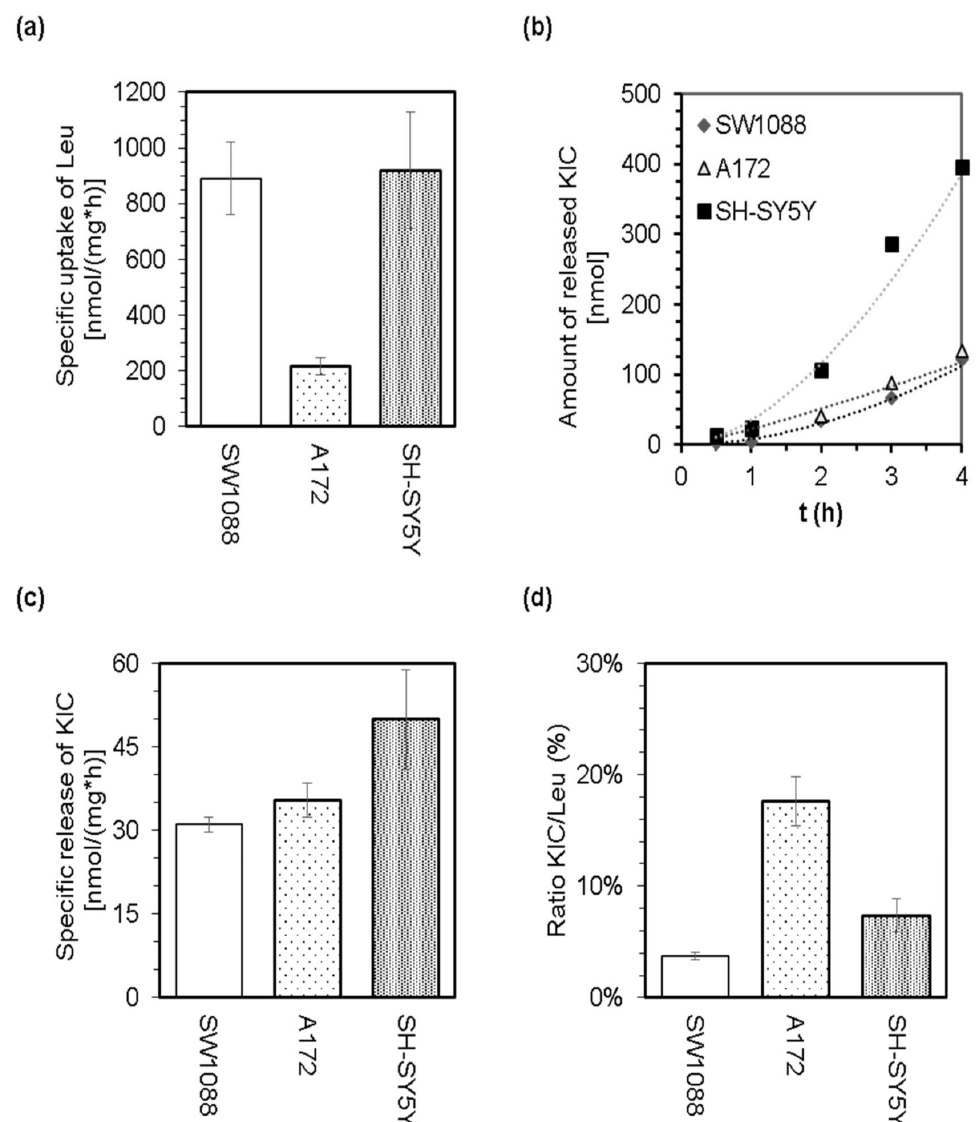
Figure 2. The capability of cultured glioma (SW1088), glioblastoma (A172), and neuroblastoma (SH-SY5Y) cells to withdraw leucine from culture media (minimal medium supplemented with 25 mM glucose and 0.8 mM leucine- 13 C 6 ) and to release KIC. LC-MS analysis of the culture media allowed estimation of specific uptake of Leu ( a ), the time dependence of KIC release ( b ), the specific release of KIC ( c ), and calculation of the ratio of released KIC to withdrawn Leu ( d